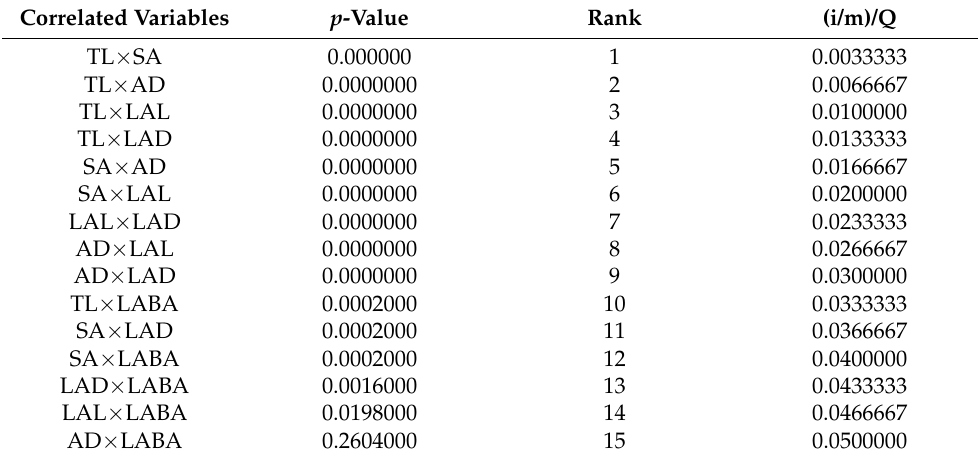
Figure 5. Correlation analysis between the six root parameters. Asterisks (*) indicate statistically significant scores, where (*) indicates significance at 0.05 level, (**) at 0.01, and (***) at 0.001 level. Table 3. Benjamini–Hochberg test for correlated variables.